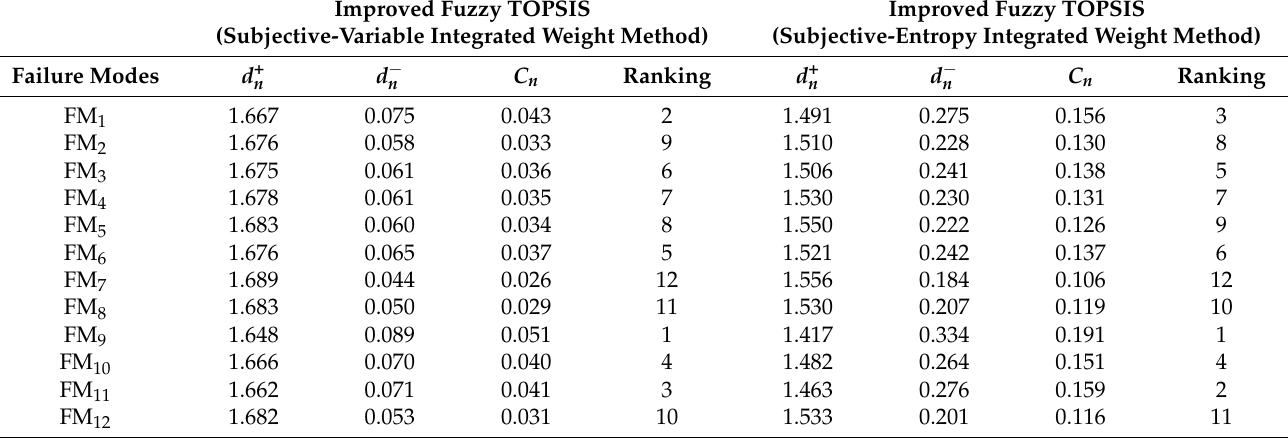
Table 9. Ranking of failure modes using the improved fuzzy Technique for Order Preference by Similarity to an Ideal Solution (TOPSIS)